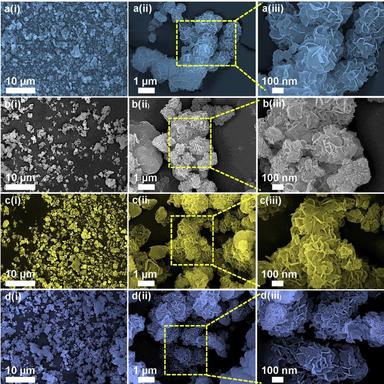
FE-SEM images of (a) (i-iii) Ni-MOF, (b) (i-iii) Ni-MOF-1, (c) (i-iii) Ni-MOF-2, and (d) (i-iii) Ni-MOF-3 samples.